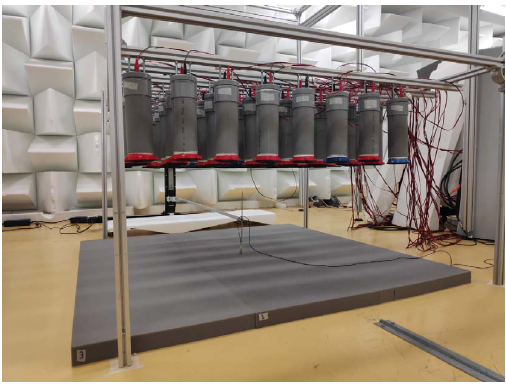
Figure 2. Picture showing the experimental setup, the 64- loudspeaker array being positioned above a layer of polyur- ethane